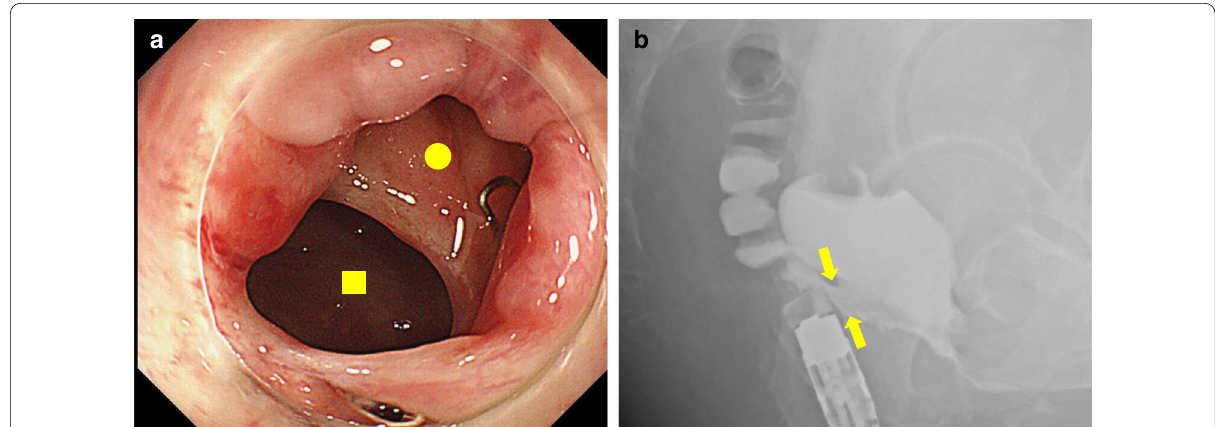
Closed circle: rectal lumen, Closed square: vaginal lumen. b Gastrografin enema shows influx of the contrast medium to the vagina through a fistula (arrows)